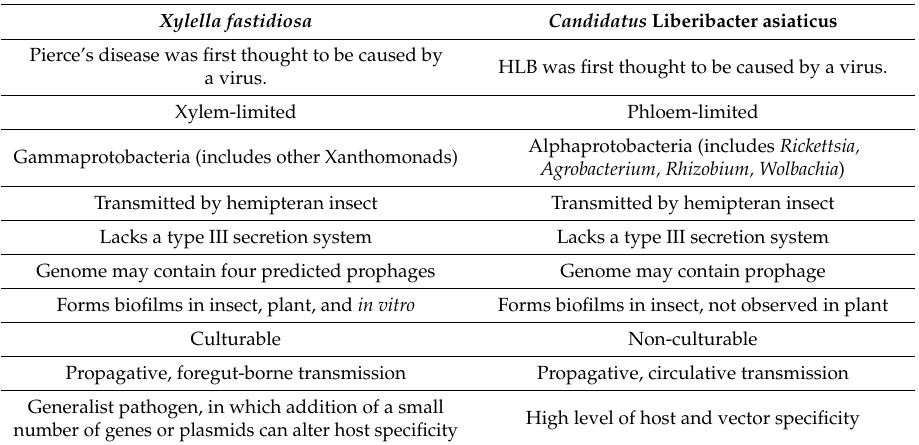
Table 1. Comparison of Xylella fastidiosa and Candidatus Liberibacter asiaticus